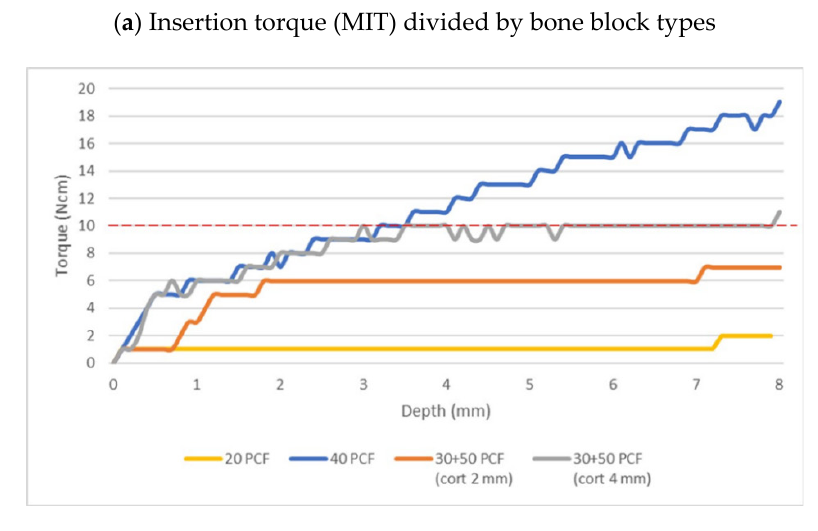
Figure 4. Graphs showing the results of the torque tester of screws on the artificial bone blocks. Maximum insertion torque depending on the thickness of cortical bone.